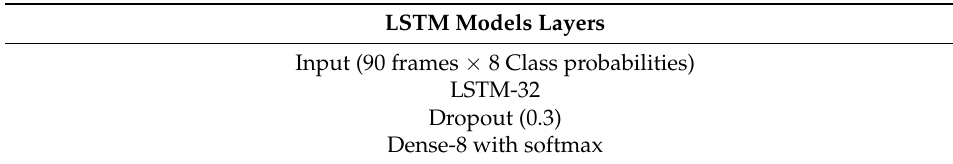
Table 12. LSTM model constructed for CNN-LSTM.